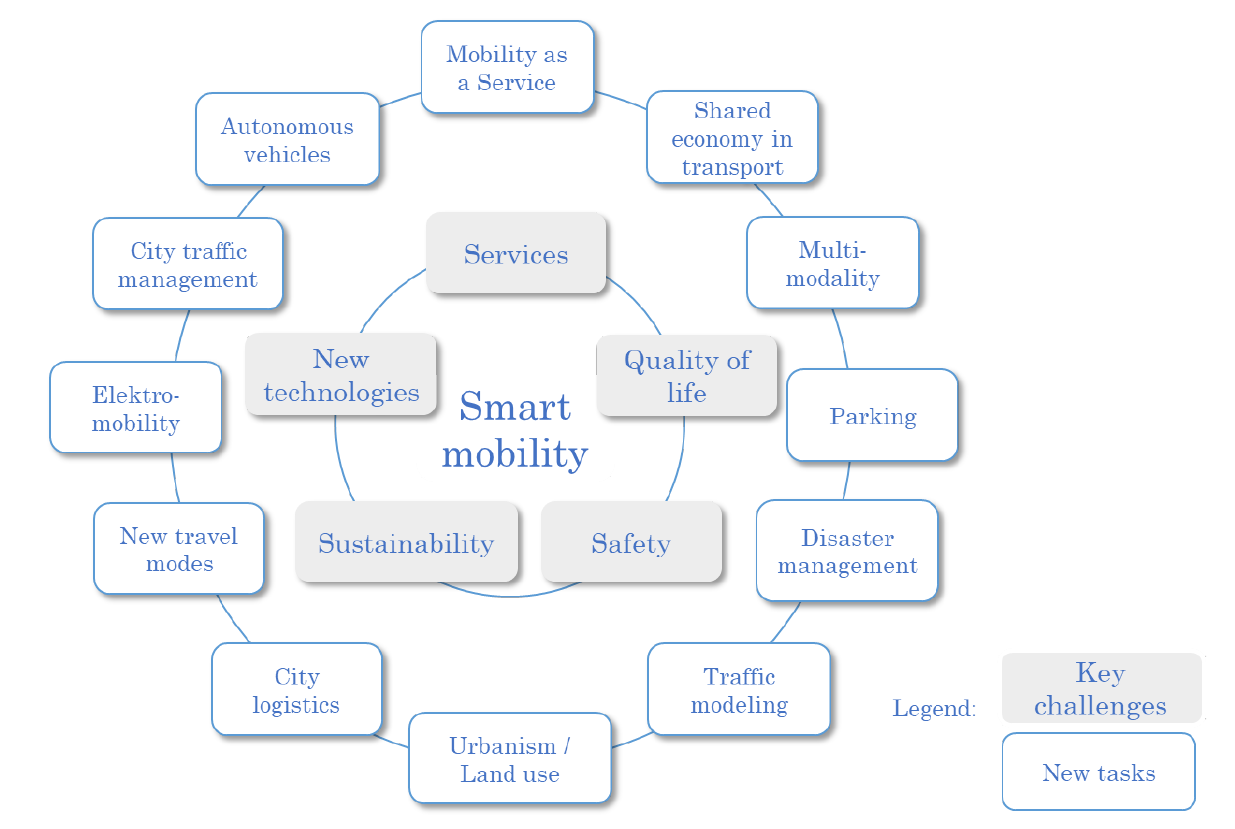
Figure 1. Overview of new trends and challenges within smart mobility (own source).